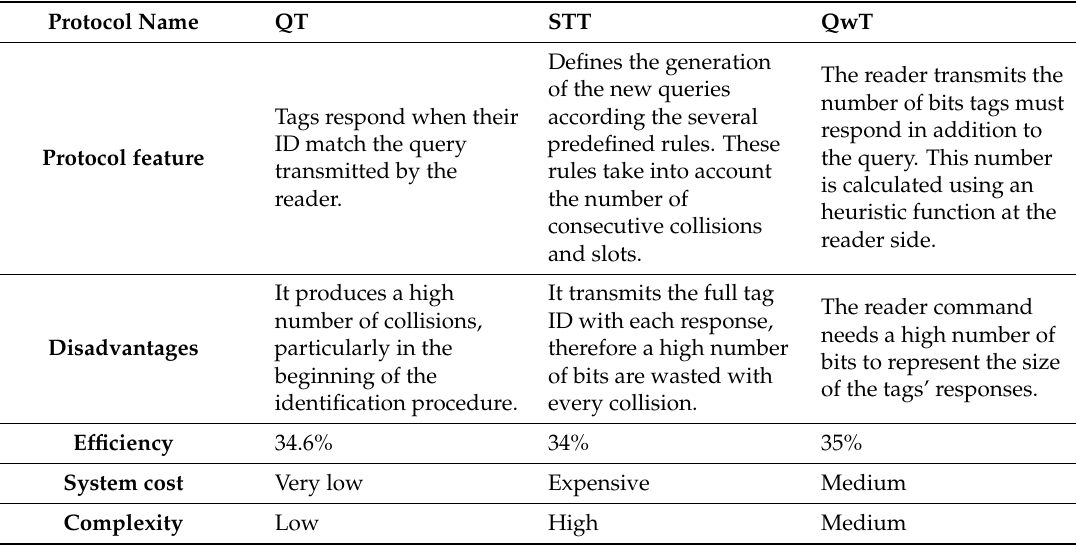
Figure 17. Flow chart of the tag ID estimation phase of the proposed FQwT protocol: ( a ) for reader; ( b ) for tags. Table 2. A comparison of standard tree-based